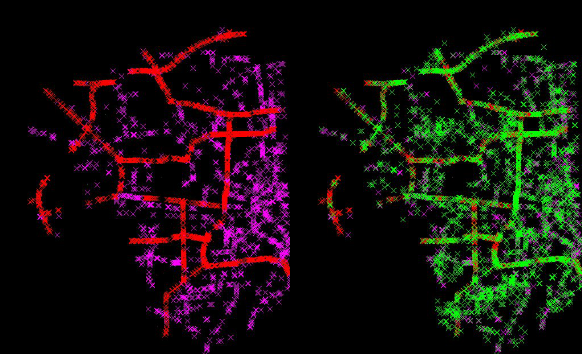
Figure 17: WorldView-2 scene, western half of Munich ( 16 . 4 × 19 . 8 km 2 ), left: manually measured reference (cars on high- ways/main roads in red, all other cars in purple), right: automati- cally detected cars overlaid in